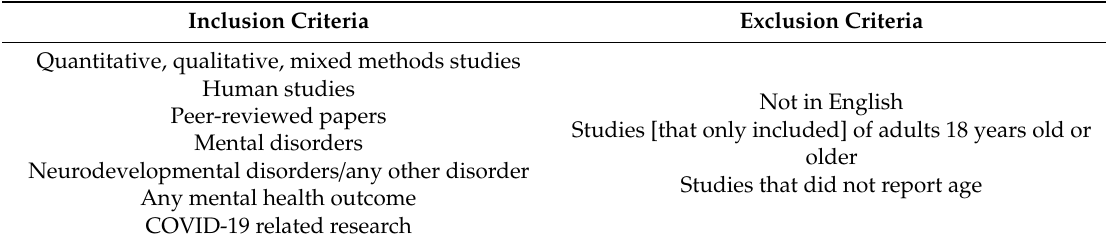
Table 1. Inclusion and exclusion